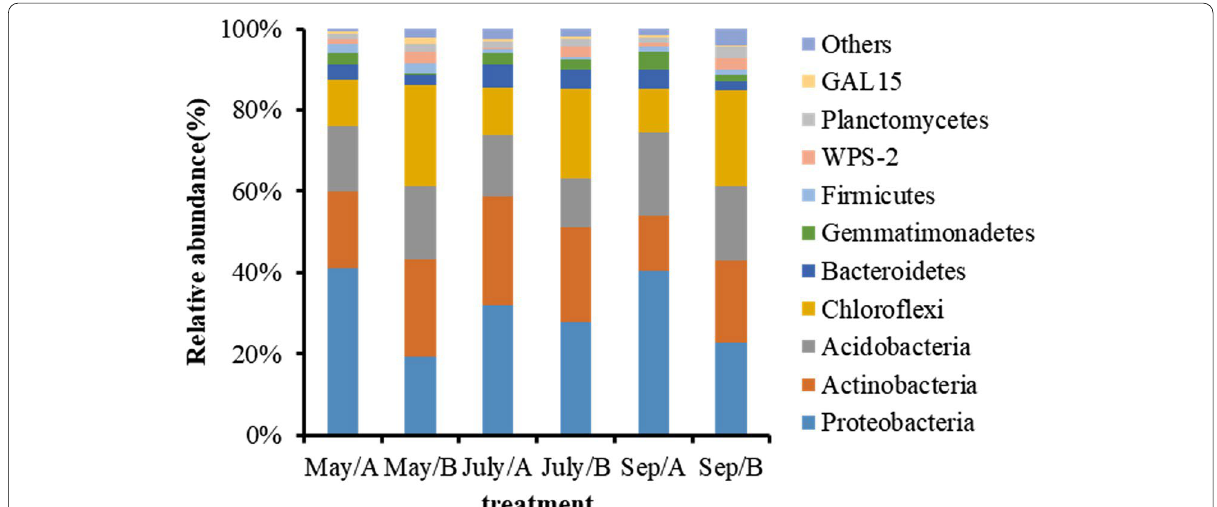
Fig. 2 Relative abundance of main bacterial phyla communities in soil in intercropping and monoculture of a banana orchard. May/A Intercropping treatment in May. May/B Monoculture treatment in May. July/A Intercropping treatment in July. July/B = = in July. Sep/A Intercropping treatment in September. Sep/B Monoculture treatment in = =